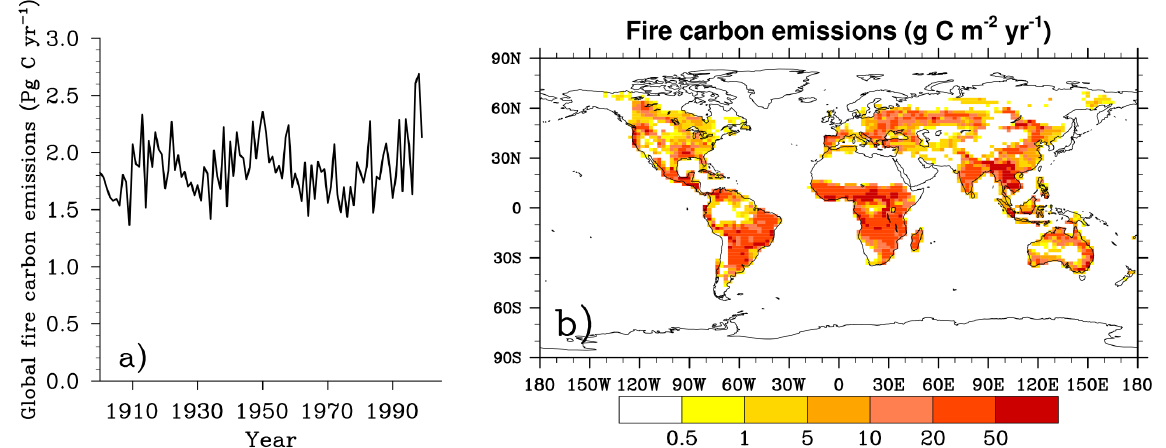
Fig. 4. Same as Fig. 1, but for fire carbon